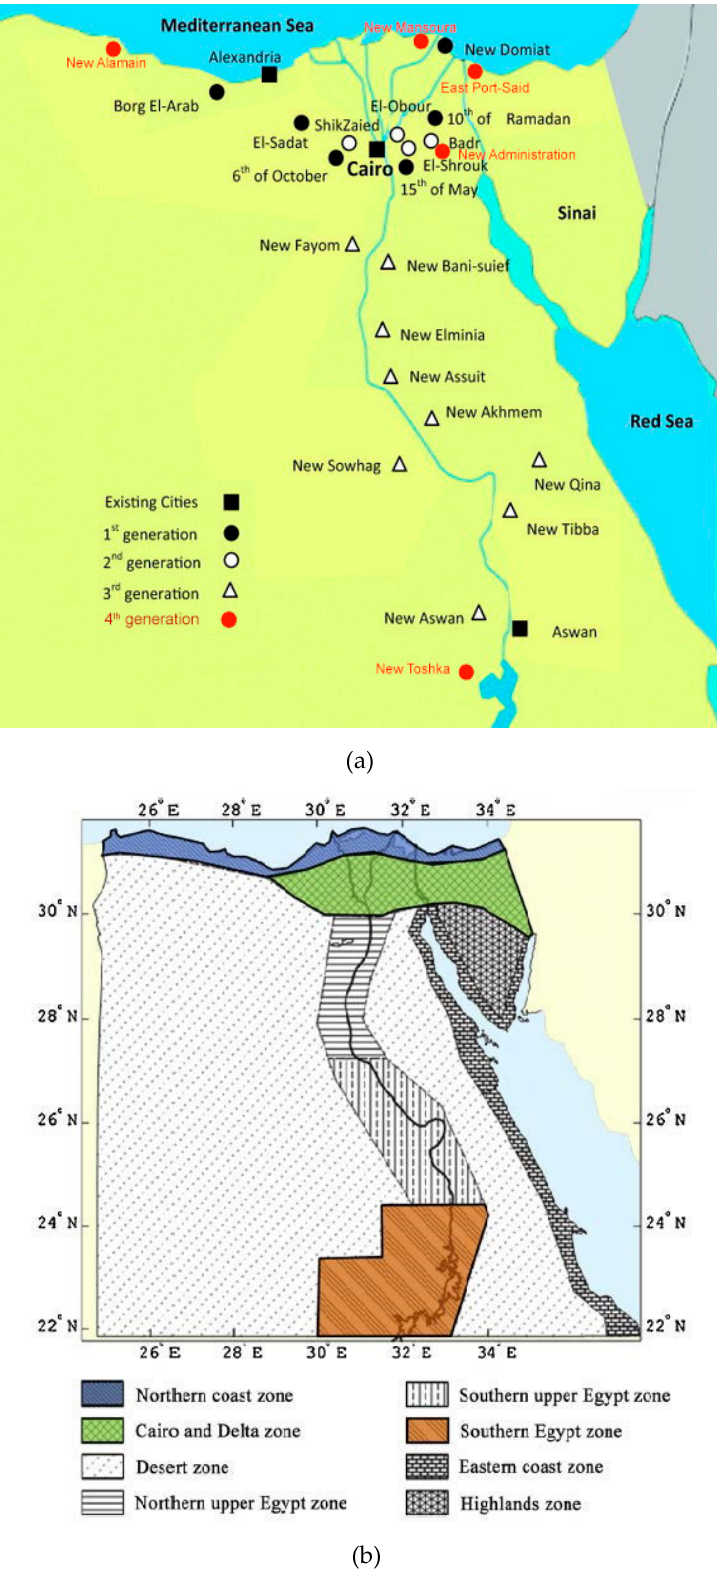
Figure 10. (a) Generations of New Cities in Egypt since 1970s, modified after (Hegazy and Moustafa 2013) [142] . (b) different climatic zones in Egypt, [139] , (North is up and scale is to